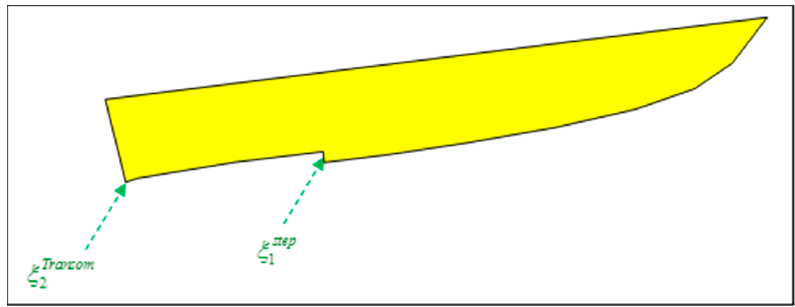
Figure 5. The steps and transom position.